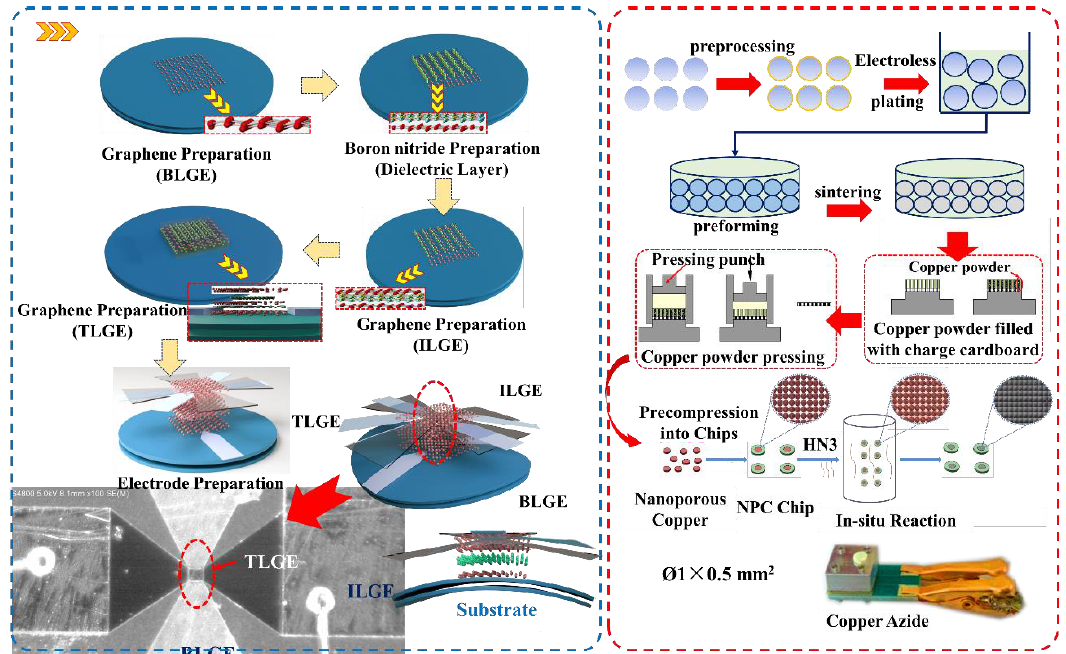
Figure 7. Fabrication processes of insurance actuator and copper azide. MI. Preparation process for the insurance